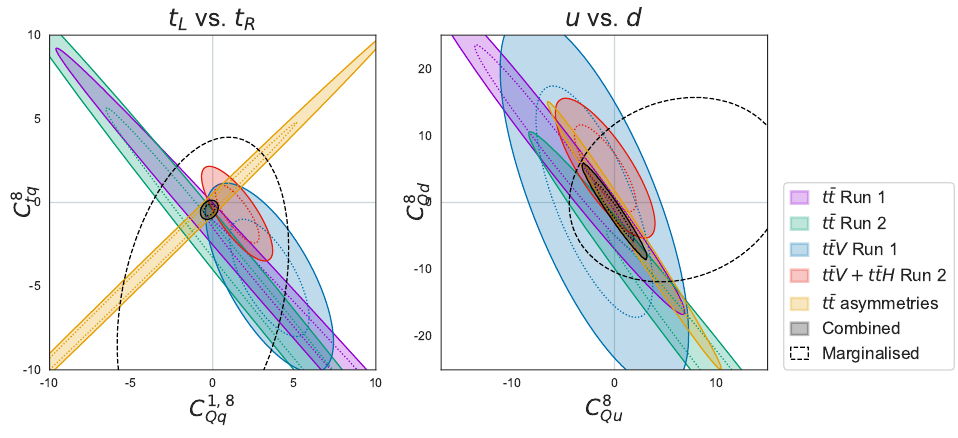
Figure 4 . Left panel: breakdown of the impacts of various top datasets on the 2-dimensional subspace of the four-fermion operators ( C 1 , 8 Right panel: similar breakdown of the impacts of various top datasets on the 2-dimensional subspace of the four-fermion operators ( C 8